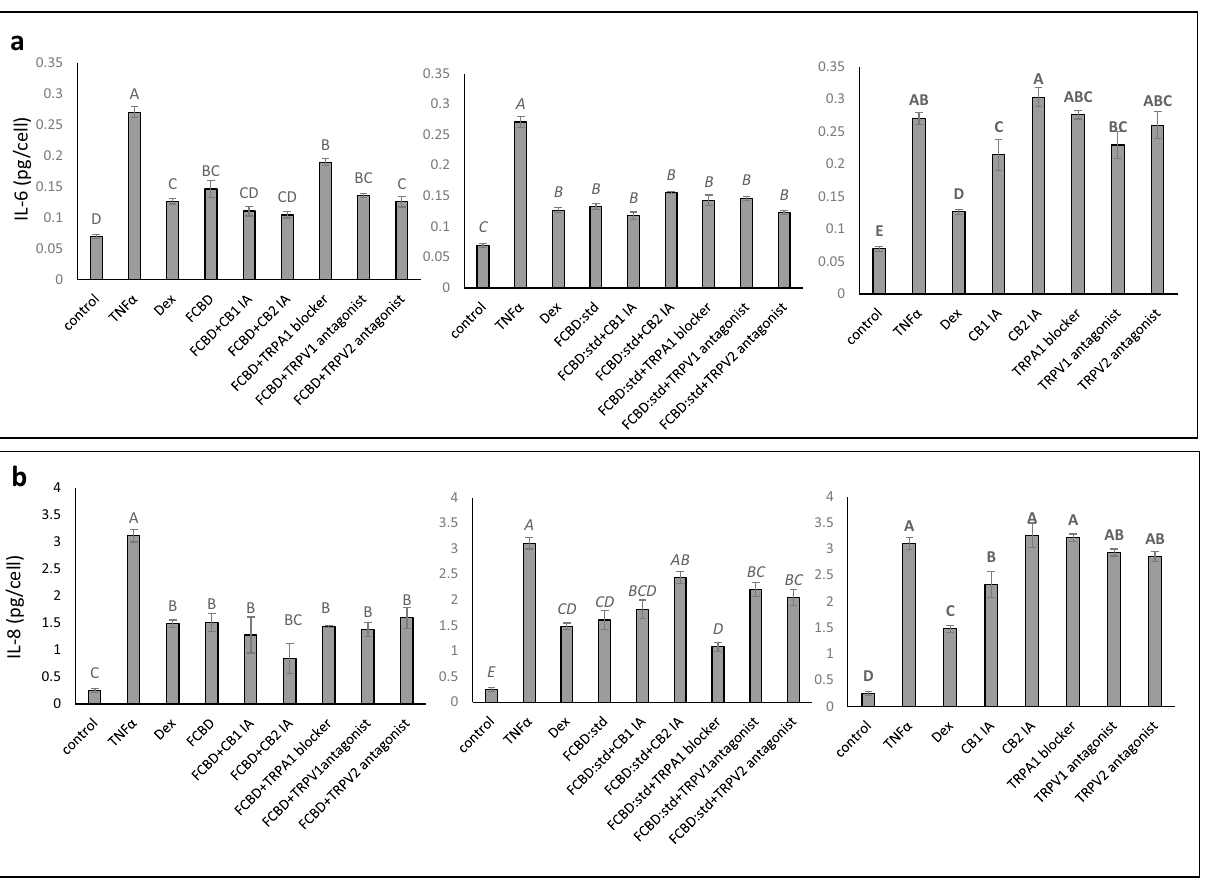
Figure 3. Levels of ( a ) IL-6 and ( b ) IL-8 in A549 cells treated with F CBD or F CBD:std with or without CB1 or CB2 inverse agonists (IA), TRPA1 blocker, or TRPV1 or TRPV2 antagonists. Cells were treated with 300 ng/mL TNFα and F CBD (FCBD) and F CBD:std (FCBD:std) at a concentration of 3.4 and 4.1 μg/mL, respectively, in the presence or absence of IA of CB1 (5 µM) or CB2 (5 and 7.5 µM for IL-6 and IL-8, respectively), a TRPA1 blocker (10 µM), or TRPV1 or TRPV2 antagonists (10 µM) for 4 h. Dexamethasone (Dex) served as a positive control at 4 µg/mL. Control (0.4% v/v methanol + 2% v/v dimethyl sulfoxide [DMSO]) treatment served as the solvent (vehicle) control; TNFα is TNFα+ solvent control treatment. Error bars indicate ± sem (n = 3). Bars labeled with different letters are significantly different from all combinations of pairs according to the Tukey–Kramer HSD test ( P ≤